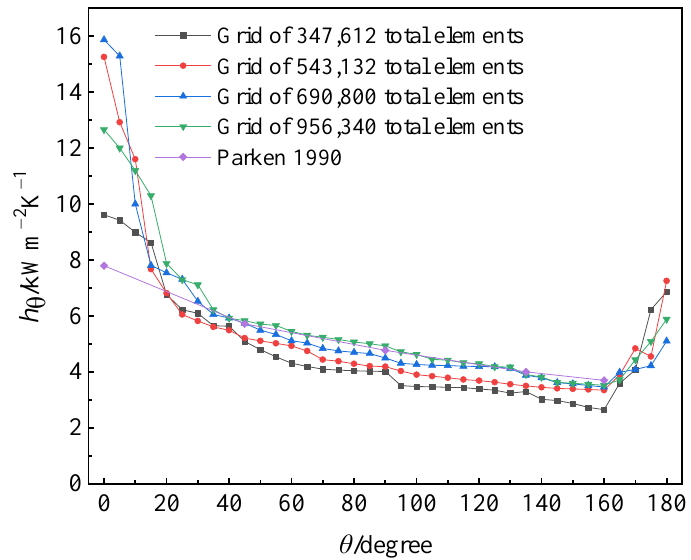
Figure 2. Variations of local heat transfer coefficient with grid numbers [24].